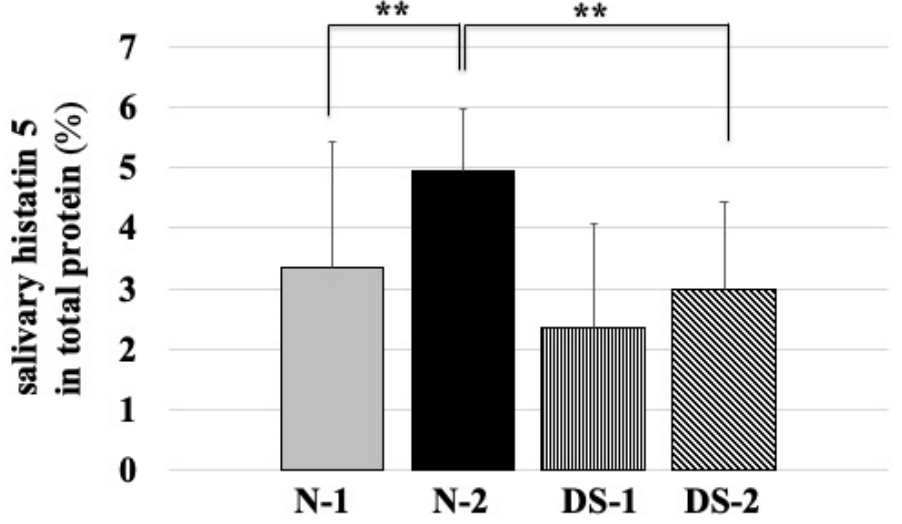
Figure 6. Comparison of salivary histatin 5 content in total protein between the Down syndrome (DS) and normal (N) groups. The DS and N groups were subdivided according to age, with the first group consisting of DS (DS-1) and normal (N-1) subjects under 20 years of age, and the second group consisting of DS (DS-2) and normal (N-2) subjects over 40 years of age. The sex composition and mean age of the study groups are shown in Table 1. One-way ANOVA test results of comparing salivary histatin 5 content in total protein in four groups and the pairwise comparison using Scheffe’s test for all four groups. ** p < 0.01; F-value 9.31.